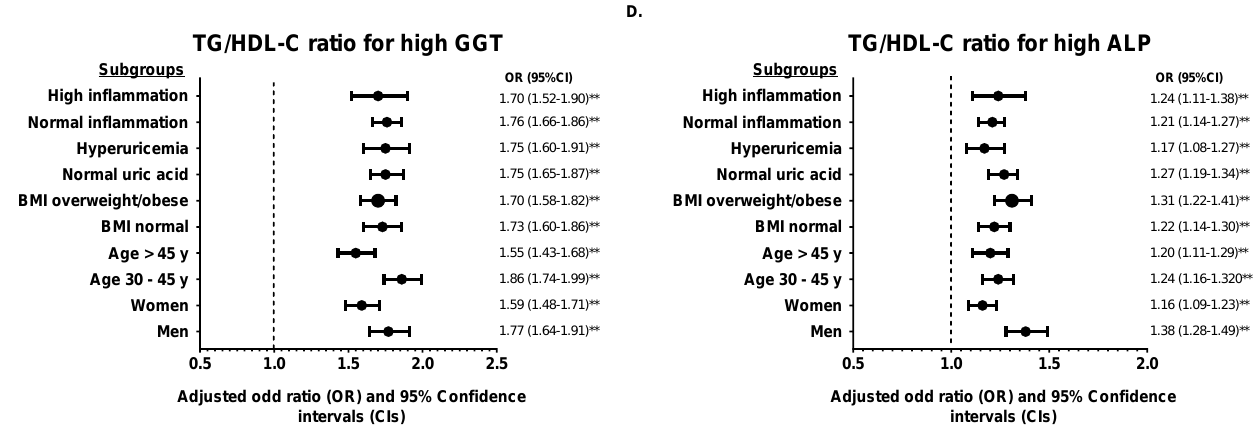
Figure 3. Subgroup analysis of the association between TG/HDL-C ratio in quintile 5 (Q4) with ( A ) high AST, ( B ) high ALT, ( C ) high GGT, and ( D ) high ALP. Quintile 3 (Q3) was used for the reference. The odds ratio (OR) was adjusted with model 2 except for stratified variables in each subgroup. ** p <